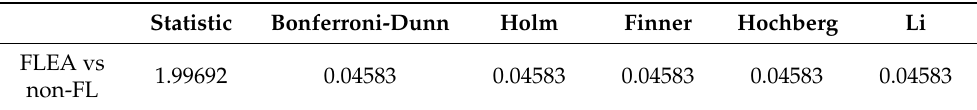
Table 10. Post hoc procedures for Quade ranks test over the twelve subjects of the Ohio T1DM data set. FLEA was chosen as the control